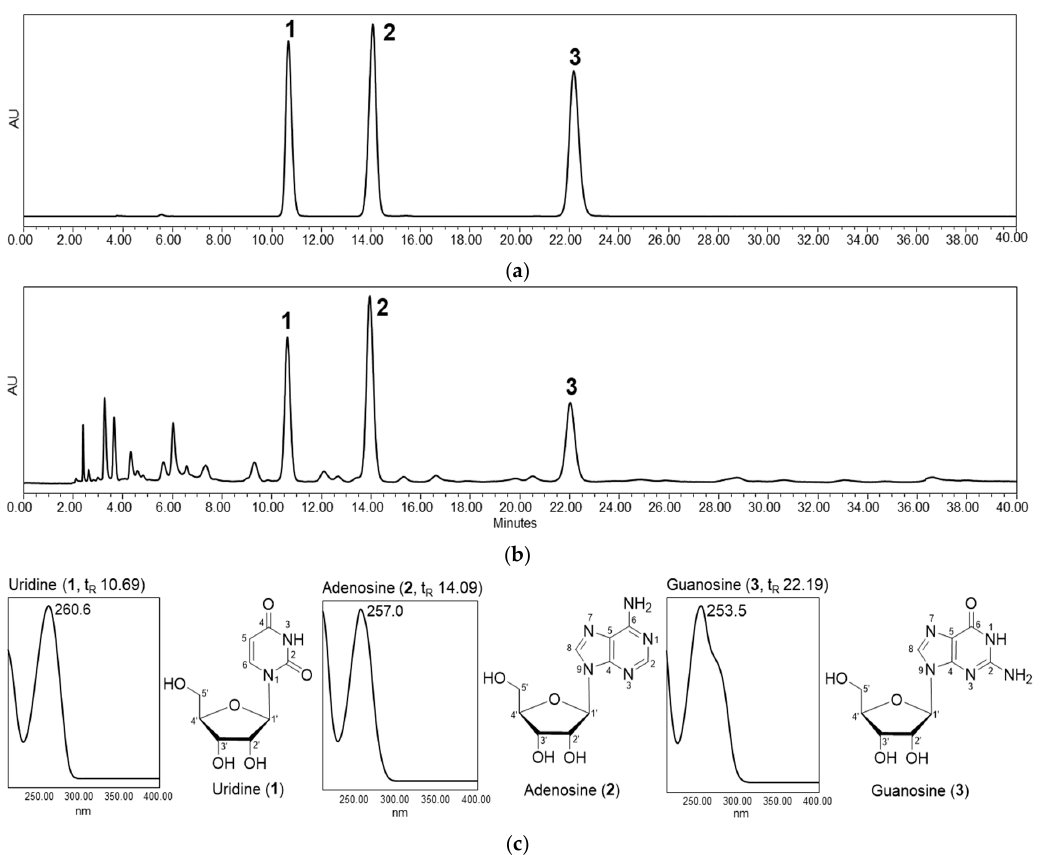
Figure 1. High-performance liquid chromatography (HPLC) profiles and chemical structures of the major compounds in Pyrus pyrifolia callus extract. ( a ) HPLC chromatograms of three standards, uridine ( 1 ), adenosine ( 2 ), and guanosine ( 3 ), and ( b ) aqueous extract from P. pyrifolia callus at 254 nm. ( c ) Structures of compounds and their ultraviolet (UV) spectra obtained with a photodiode array detector (210–400 nm).